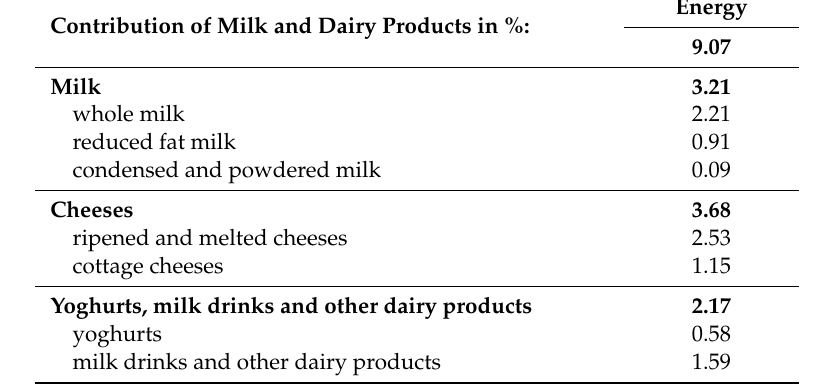
Table 3. Dairy sources of energy contribution to the average Polish diet (in % of total energy